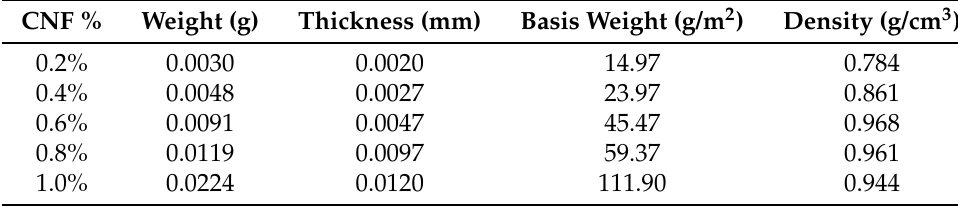
Table 2. Physical properties of CNF-OD films at different CNF